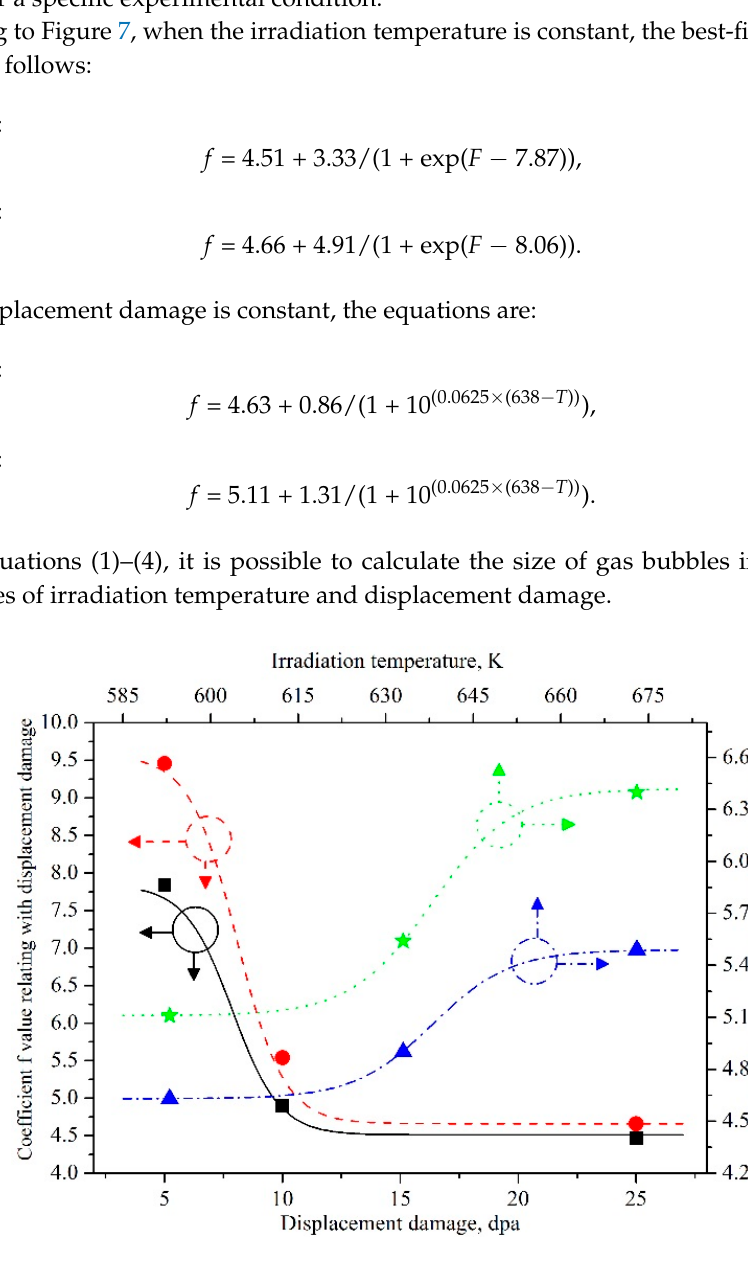
Figure 7. The functional coefficient f vs. experiment parameters during the growth of krypton bubbles. The solid line with black color represents f vs. displacement damage for Zr alloy #1; the dash line with red color represents f vs. displacement damage for Zr alloy #2; the dot line with blue color represents f vs. irradiation temperature for Zr alloy #1; the dot line with green color represents f vs. irradiation temperature for Zr alloy #2.